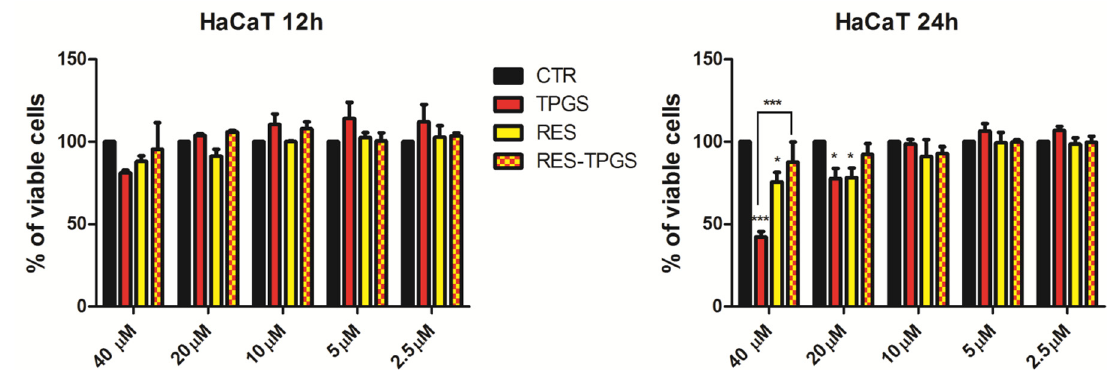
Figure 10. Viability of human keratinocyte HaCaT cells treated with increasing concentrations of RES, RES-TPGS 1:4 lyophilized powder, providing the same raw RES concentration, and with the TPGS concentration (2.01 µ M, 4.02 µ M, 8.04 µ M, 16.07 µ M, 32.15 µ M) according to the sample DL%. The experiments were carried out three times and data are represented as the average ± S.D. * p <0.05, *** p < 0.001.